Question: Condense the content of this figure into a single sentence.
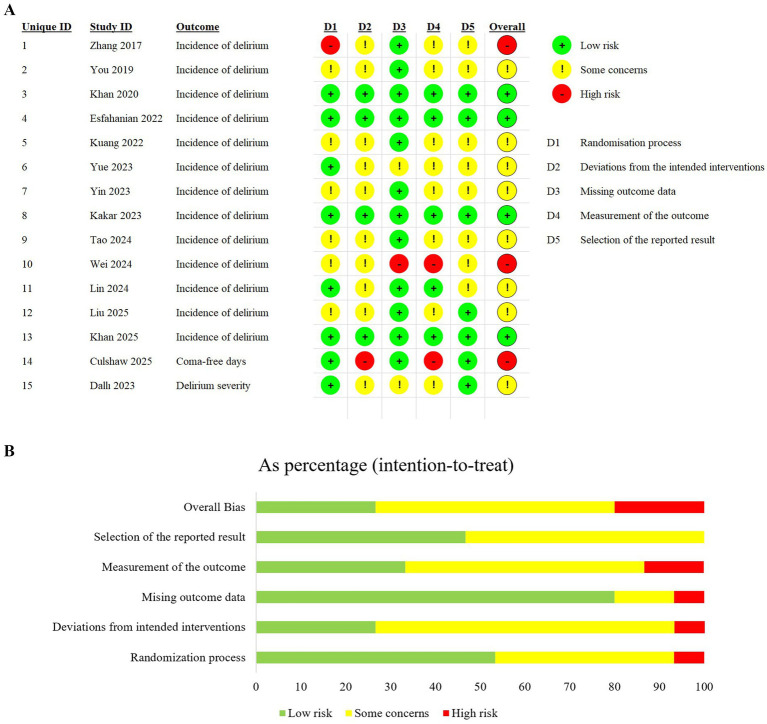
Answer: Risk of bias assessment for delirium-related outcomes. (A) Traffic light plot of risk of bias for each included study. (B) Risk of bias summary presented as percentages across all domains.